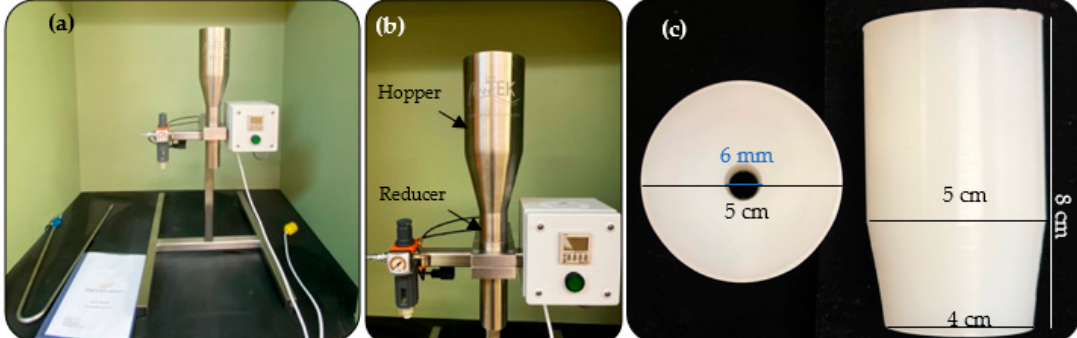
Figure 1. ( a ) A seed flow meter (Centor Oceania’s Lab FlowTek, Victoria, Australia) was used to determine the seed flowability. ( b ) Close up of hopper and where the reducer inserts. ( c ) The reducer was custom-made in Cornell AgriTech from High-density polyethylene (HDPE) and modified the seed flow meter; its use is feasible for small-seeded crops in small batches of 25 g.